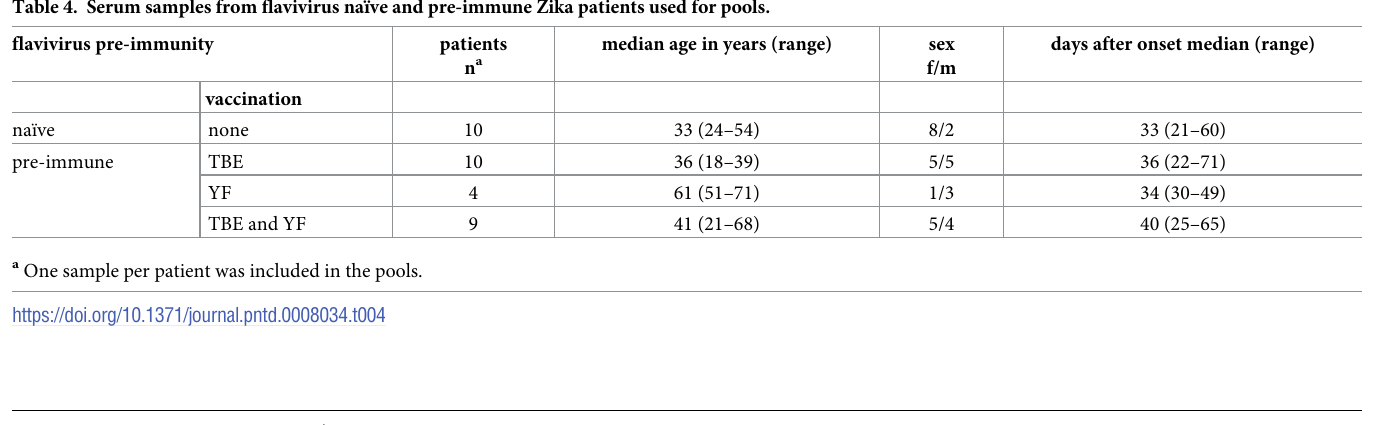
To assess the effect of pre-existing flavivirus immunity on the patterns of antibody responses in primary Zika virus infections, we analyzed serum samples from laboratory-confirmed Zika patients (travelers returning from Zika-endemic regions) with and without prior TBE and/or YF vaccination (Table 3). Since these samples were not derived from a prospective study but were randomly received for diagnostic purposes from travelers returning with Zika virus infec- tions, the groups were relatively heterogeneous with respect to age and comprised mostly adults. Flavivirus pre-immunity due to vaccination was confirmed by TBE and YF neutraliza- tion assays as described in Methods. The time points of vaccinations, however, have not been documented for the diagnostic samples used. Our analyses included the quantification of Zika virus-specific and flavivirus cross-reactive